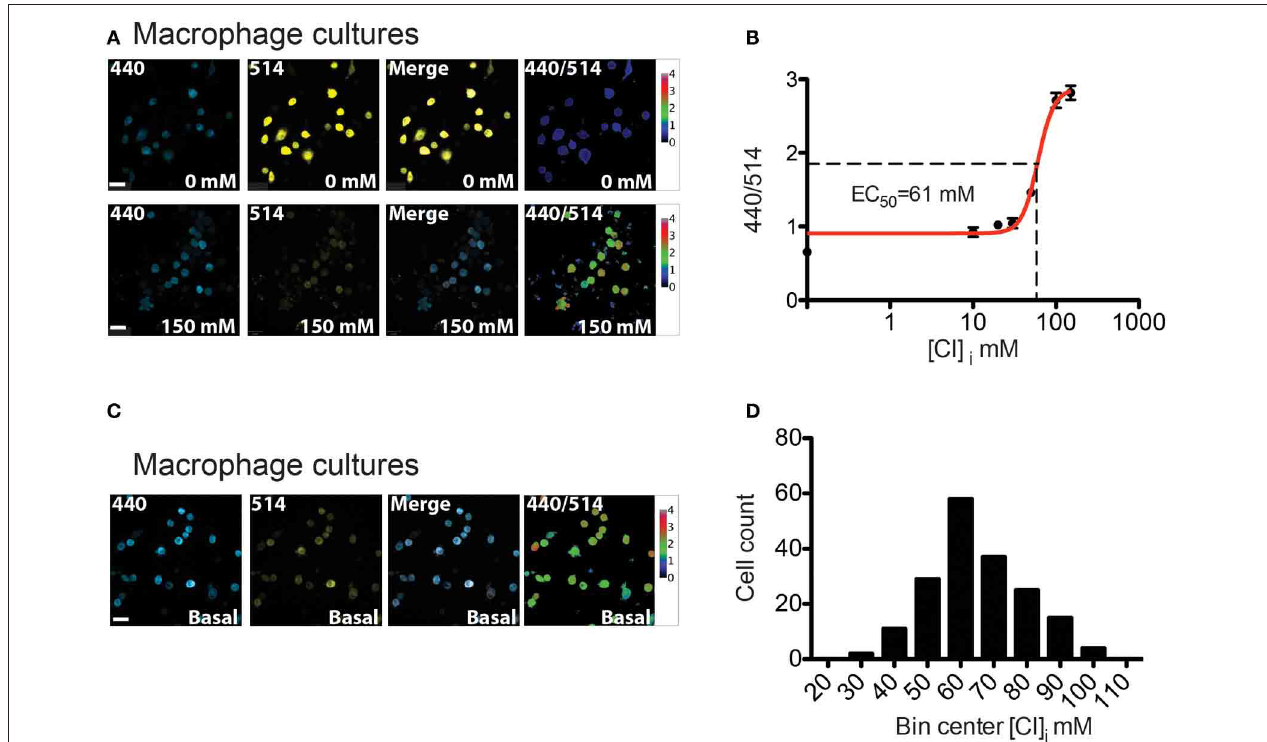
FIGURE 8 | [Cl] i calibration and measurement in peritoneal macrophages from LysM-Cre::Cl-Sensor mice. (A) Representative images of permeabilized peritoneal macrophages cultures which were subjected to β -escin treatment followed by the addition of 0mM (top) or 150mM (bottom) extracellular Cl − solutions. From left to right: image captured with the 440nm laser (blue), 514nm laser (yellow), merged and 440/514 images. Scale bars